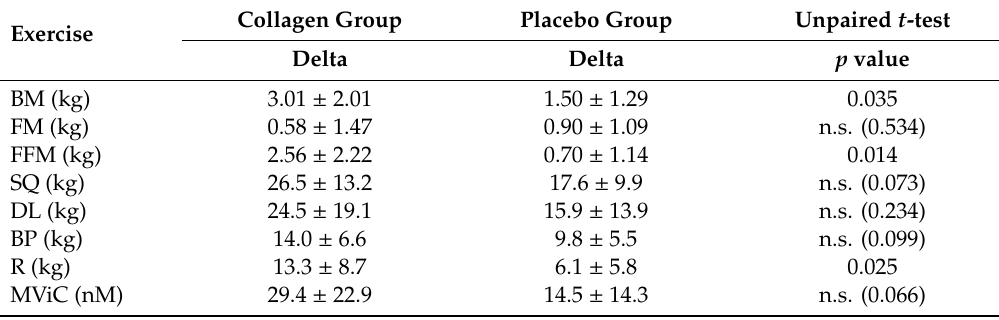
Table 2. Di ff erences (mean ± SD) in post-test values between the collagen (COL) group and placebo (PLA) group in body mass (BM), fat mass (FM), fat free mass (FFM), the squat test (SQ), dead lift (DL), bench press (BP), rowing (R), and isometric strength testing (MViC) before and after the 12-week intervention period. Unpaired t -tests were used to detect di ff erences between both groups after the intervention (level of significance was set to p ≤